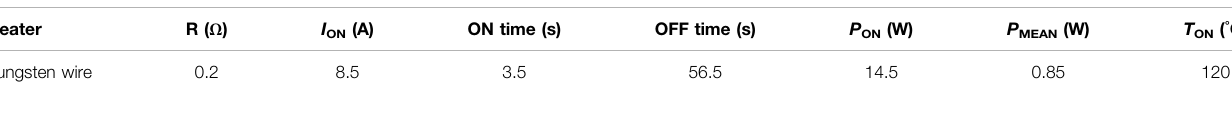
TABLE 1 | Electrical and thermal characteristics of the heater.